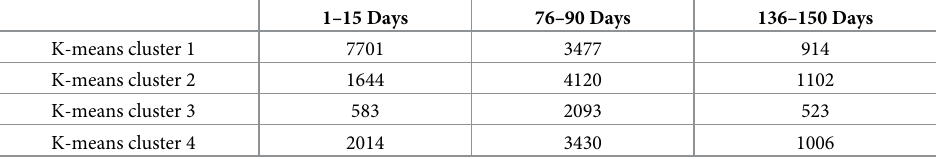
Table 3. Joint frequencies of players in spacing group as defined by k-means cluster (rows) versus time in days delta between 1st and 95th match